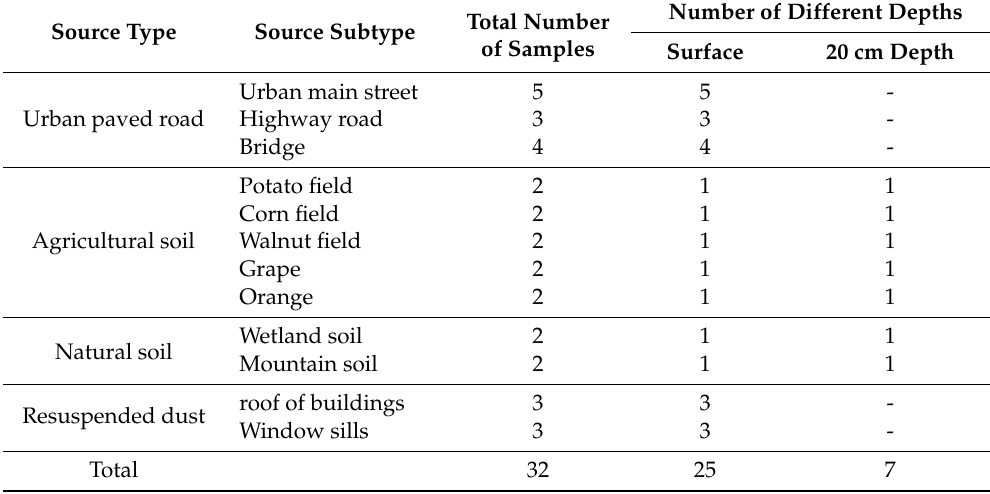
Table 1. Summary of source types of geological dust